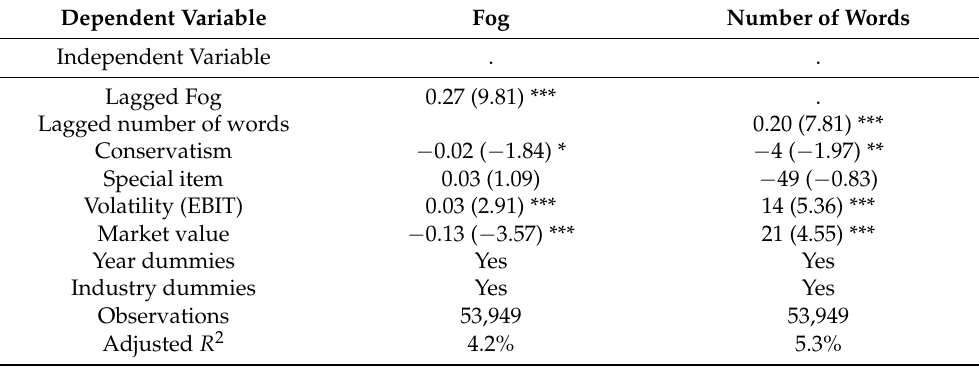
Table 2. The determinants of Fog and number of words. Dependent Variable Fog Number of Words Independent Variable . .